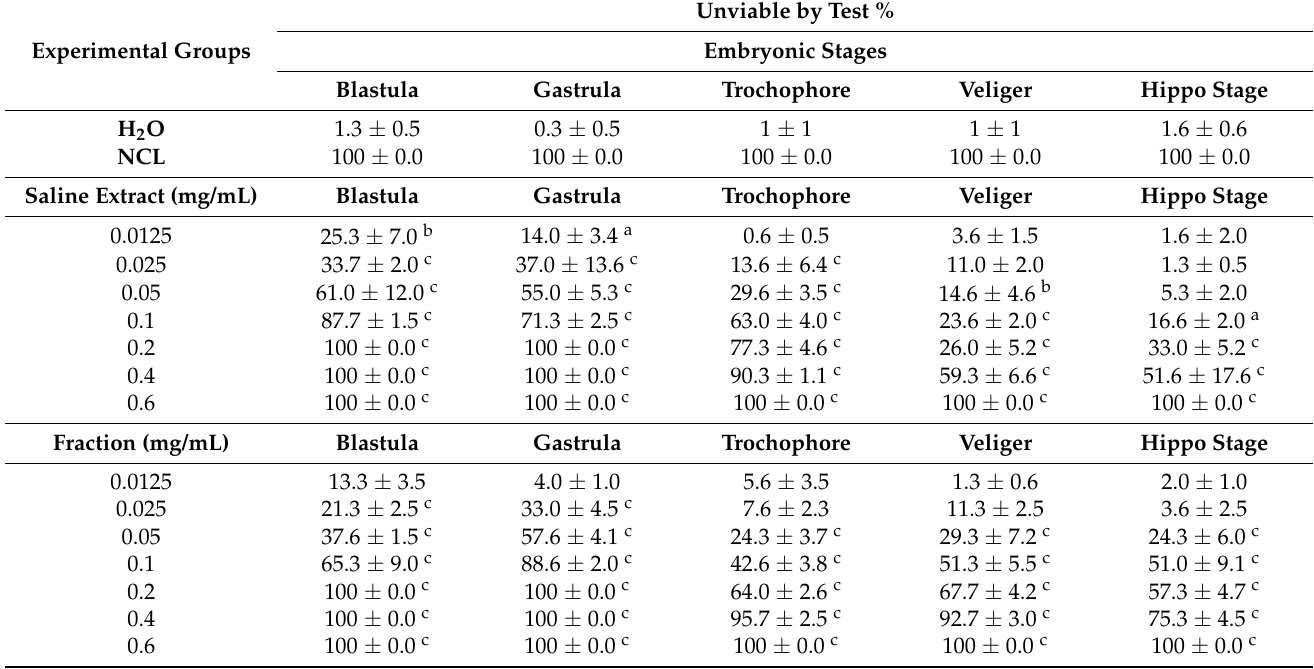
Table 1. Unviability of the different embryonic stages of B. glabrata exposed to saline extract and fraction of B. monandra .